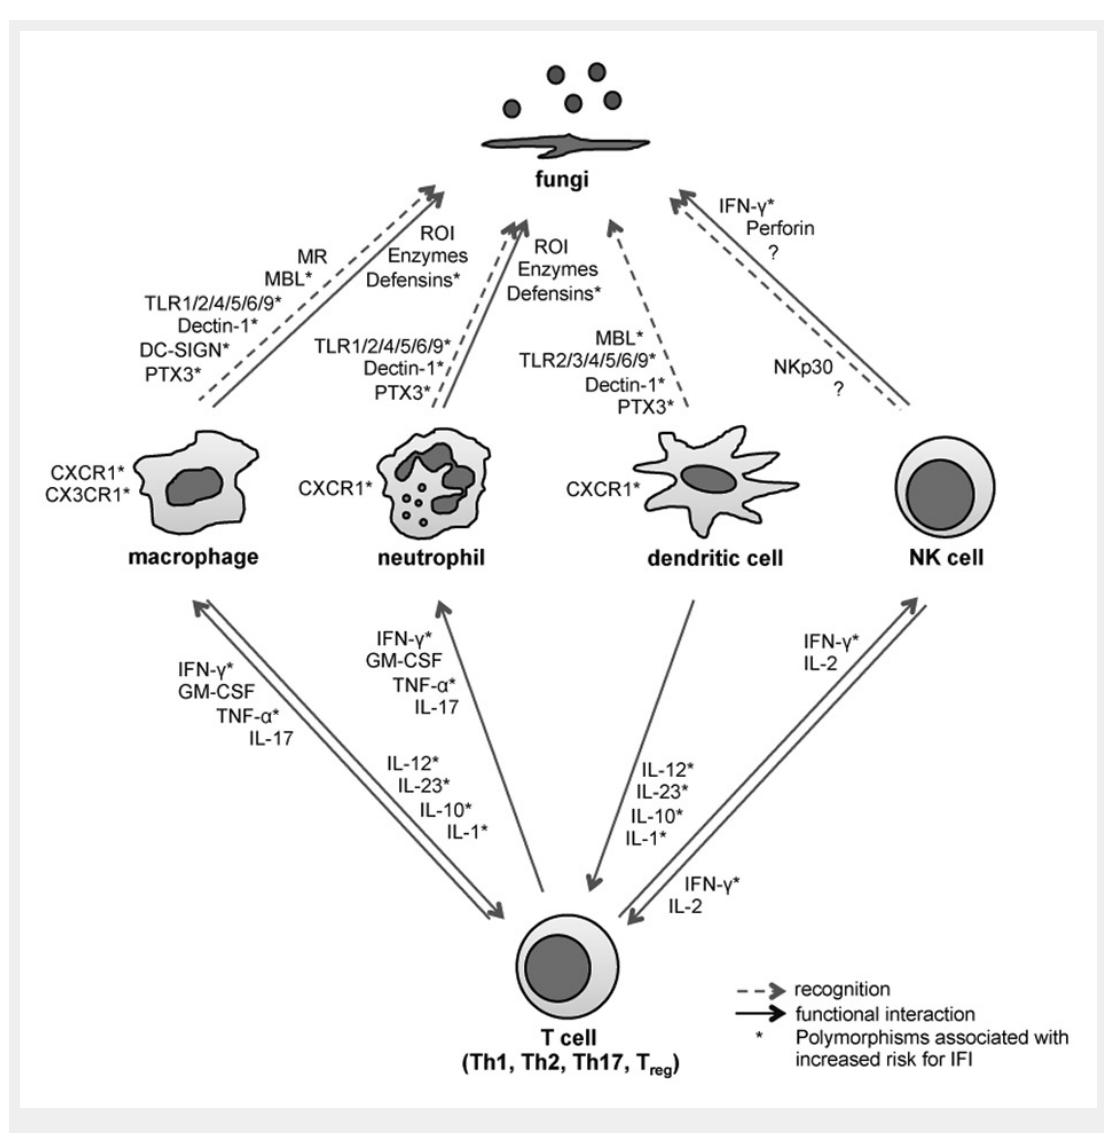
Single nucleotide polymorphisms pathways of innate and adaptive antifungal immunity associated with increased risk for invasive fungal infections. NK cell = natural killer cell; MR = mannose receptor; MBL = mannose-binding lectin; TLR = Toll-like receptor; PTX3 = pentraxin 3; ROI = reactive oxygen intermediates; IFN = interferon; GM-CSF = granulocyte macrophage colony stimulating factor; TNF = tumour necrosis factor; IL = interleukin ; IFI = invasive fungal